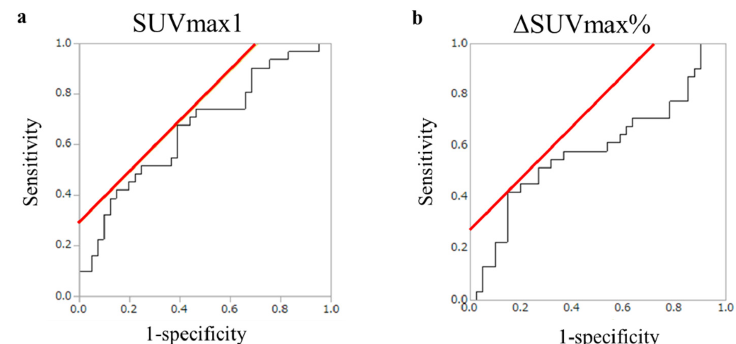
Figure 3. Selection of the cut-off point for and Δ SUVmax%. ( a ) Receiver operator characteristic (ROC) curves of the maximum standardized uptake value at 60 min (SUVmax1) with reference to relapse events within one year of pancreatectomy ( n = 72). SUVmax1 at the cut-off value was 7.18, and the area under the curve (AUC) was 0.59 (95% confidence interval (CI) 0.44–0.72). ( b ) ROC curves of ∆ SUVmax% with reference to relapse events within one year of pancreatectomy ( n = 72). ∆